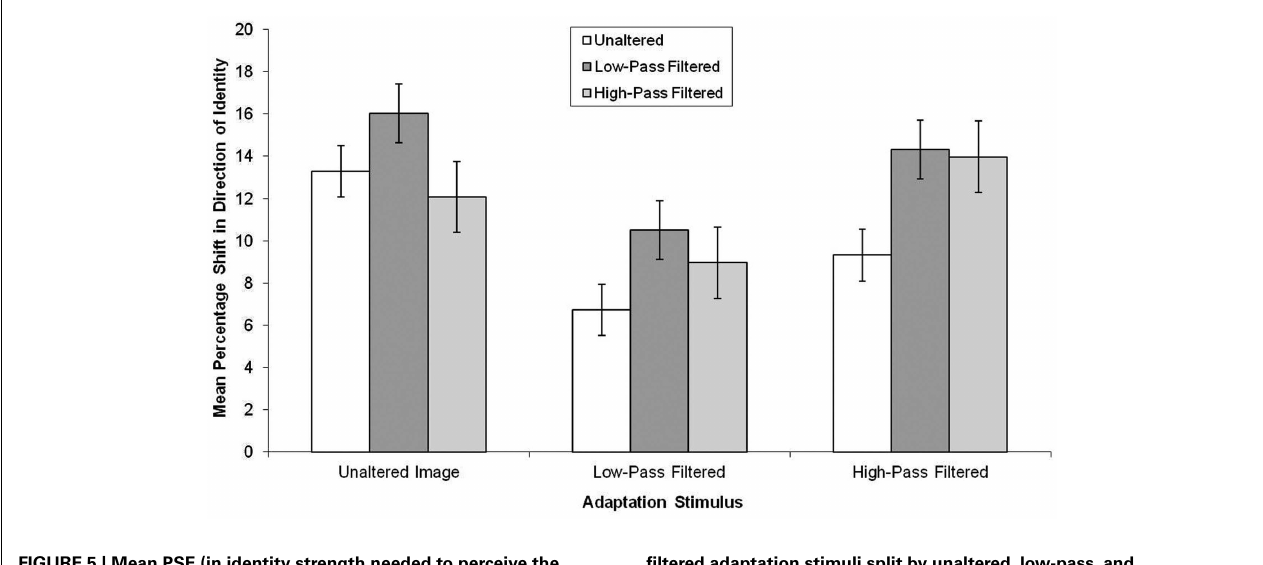
FIGURE 5 | Mean PSE (in identity strength needed to perceive the adapted identity) shift pre- to post-adaptation (as a measure of the magnitude of the aftereffect), for unaltered, low-pass, and high-pass